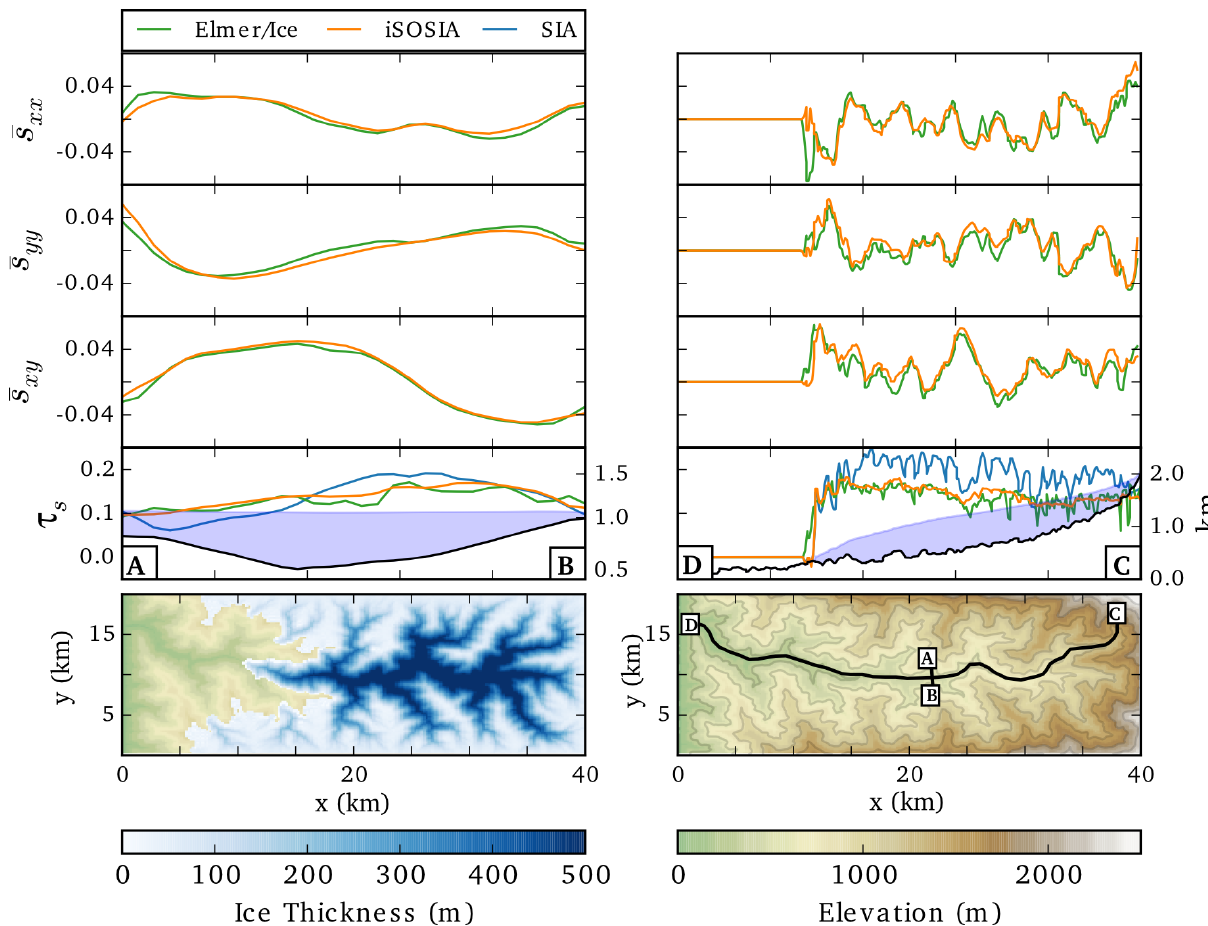
Figure 3. iSOSIA (orange) and Elmer/Ice (green) stress components in MPa along a transverse (left column) and a longitudinal (right column) profile. Upper three rows compare the higher-order depth-averaged horizontal stress components. The fourth row shows the basal shear stress along the same profiles. The SIA driving stress (Eq. 15) is also shown for comparison (blue line). The fourth row also shows bed topography (black line) and ice thickness (blue shaded area). Notice that elevation is indicated on the right axis. Bottom left panel shows ice thickness. The positions of the two profiles (A–B and C–D) are shown in the bottom right panel. Note that the bottom panels are map views of the 3-D model (Fig. 1a,